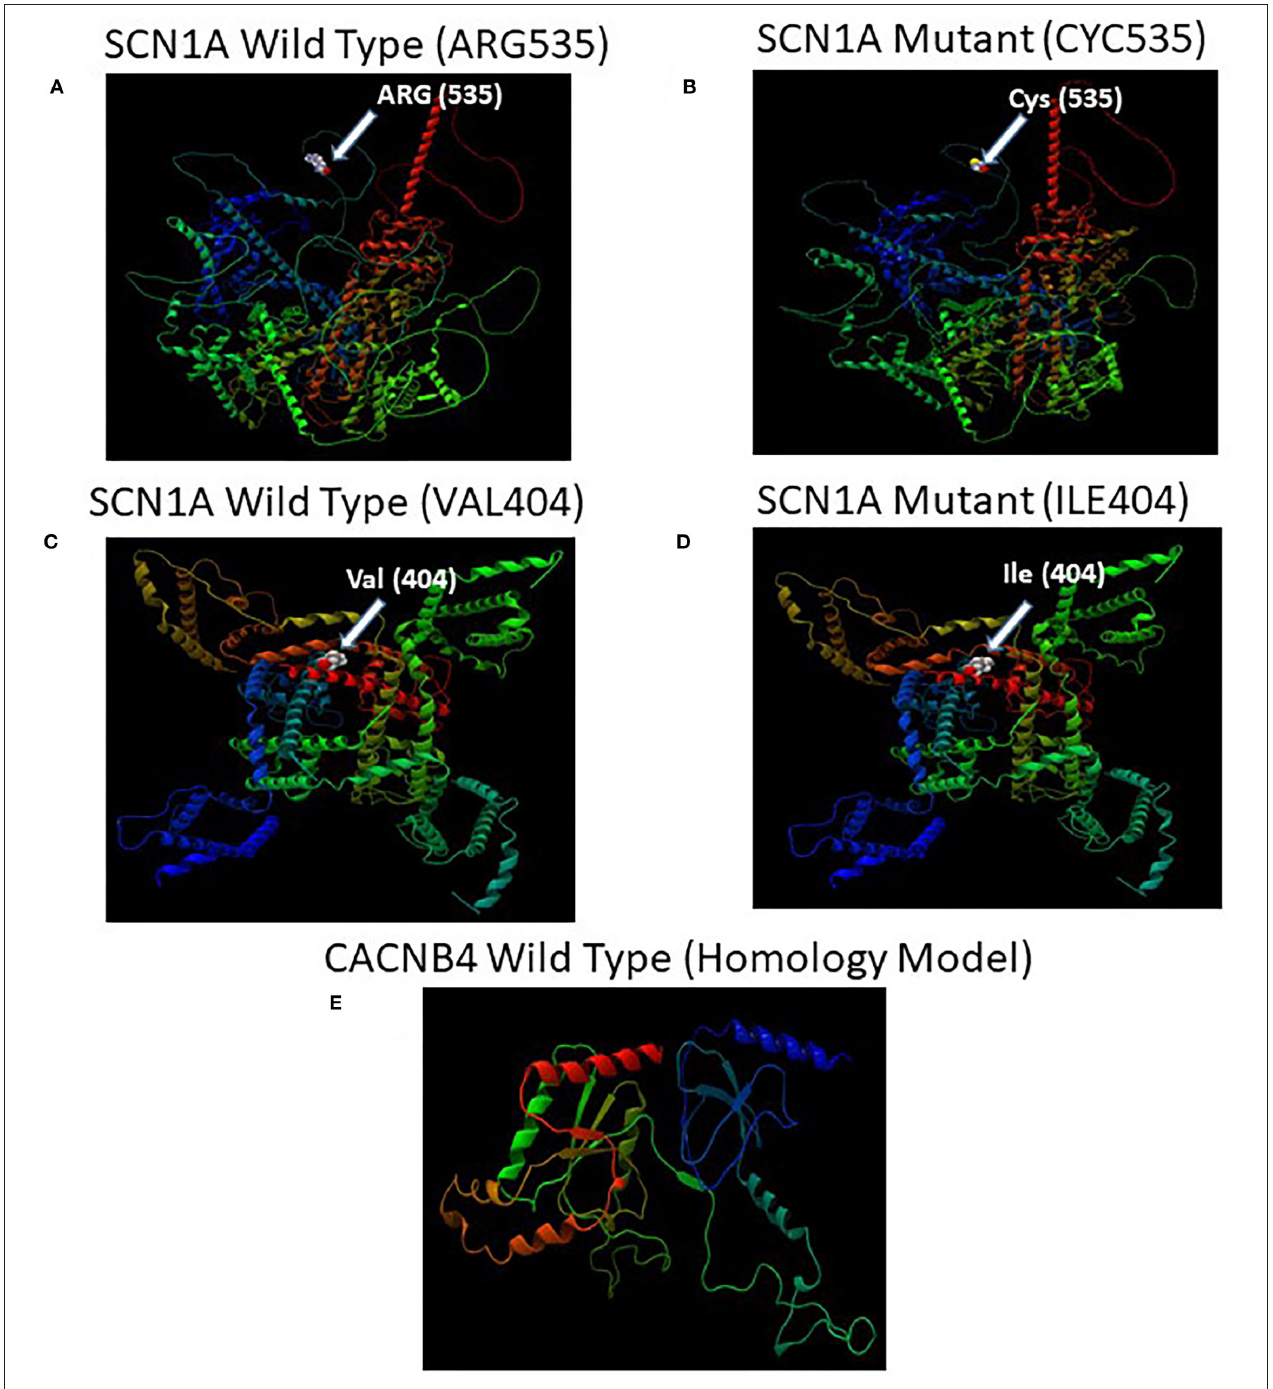
FIGURE 5 | (A) Illustration of the predicted wild-type and mutant structures (AF-P35498-F1) of SCN1A and the prediction for the position of p.Arg535Cys. (B) The amino acid Arg at position 535 in the wild-type SCN1A and Cys at position 535 in the mutant SCN1A are shown as space-filling [(Calotte or Corey, Pauling, and Koltun (CPK)] models. (C) Illustration of the wild-type and mutant structures (PDB ID: 7DTD) of SCN1A and the prediction for the position of p.Val404Ile. (D) The amino acid Val at position 404 in the wild-type SCN1A and Ile at position 404 in the mutant SCN1A are shown as space-filling [(Calotte or Corey, Pauling, and Koltun (CPK)] models. (E) The 3D structure of the wild-type CACNB4 structure was designed using the SWISS-MODEL homology modeling platform (27).